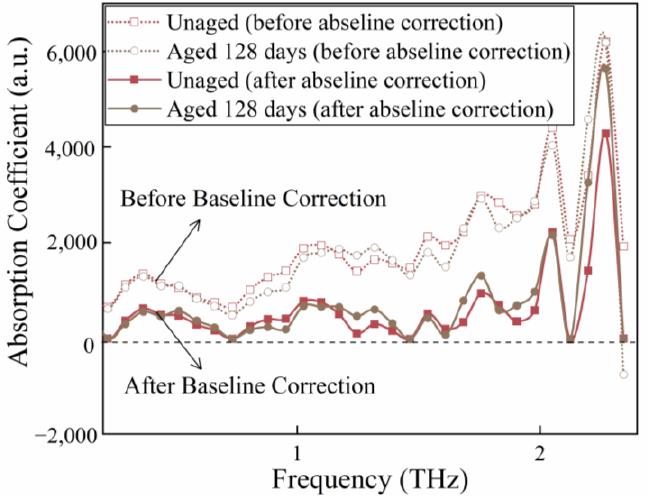
Figure 4. Absorption spectra of the unaged and aged 128 days insulating paper before and after baseline correction.